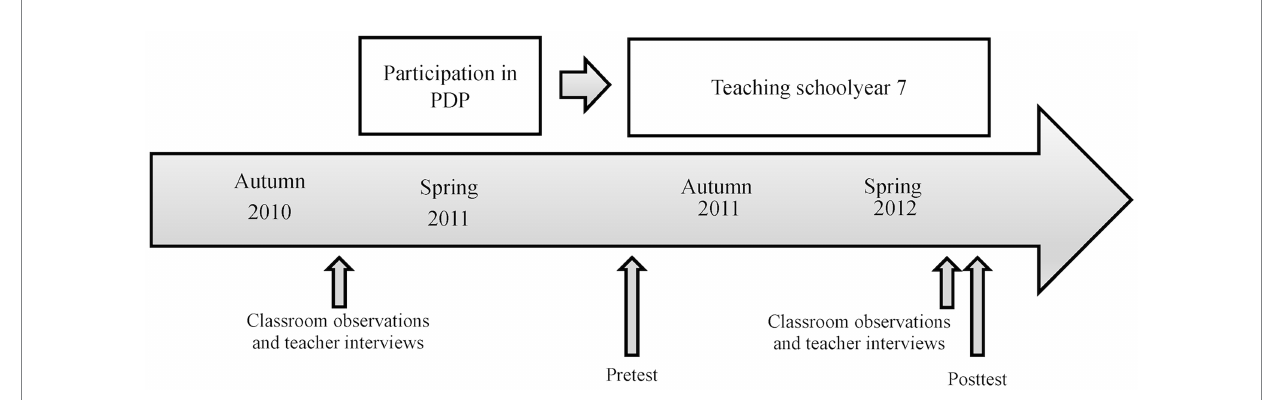
FIGURE 1 Timeline for data collection and teachers’